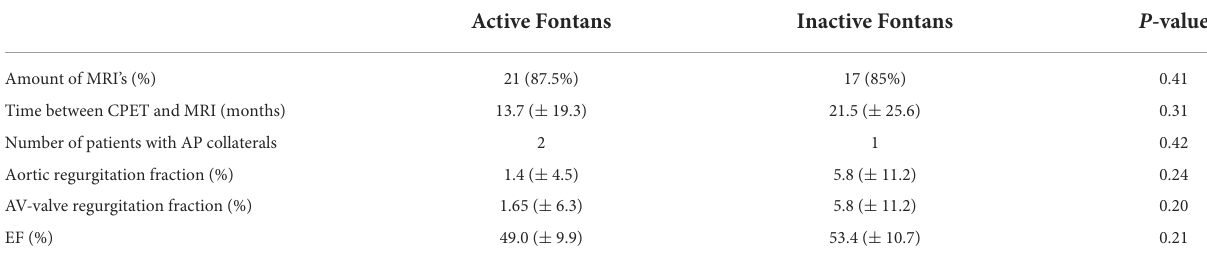
TABLE 4 MRI measurements as means with standard deviation in brackets and the p -value for the t -test between the two groups.